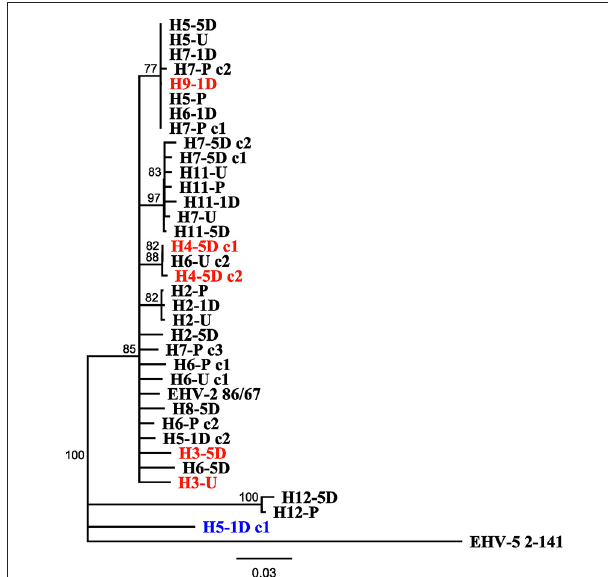
FIGURE 3 | Neighbor joining phylogenetic tree illustrating relationships amongst sequences obtained from study, reference EHV-2 87/67 strain (GenBank accession number U20824.2) and outgroup EHV-5 Strain 2-141/67 (GenBank accession number KM924295). Sequences are labeled according to Horse (H-), time point of sample taken [Pre Transport [-P], Unloading [-U], 1 day post transport [-1D], 5 days post transport [-5D]] and clone (c-) number if more than one isolate was sequenced from each sample. Tip labels highlighted in red denote sequences obtained from horses positive for EHV-2 only after transport, tip labels in blue denote sequences that may have originated from reactivated virus. Scale bar represents substitutions per site.